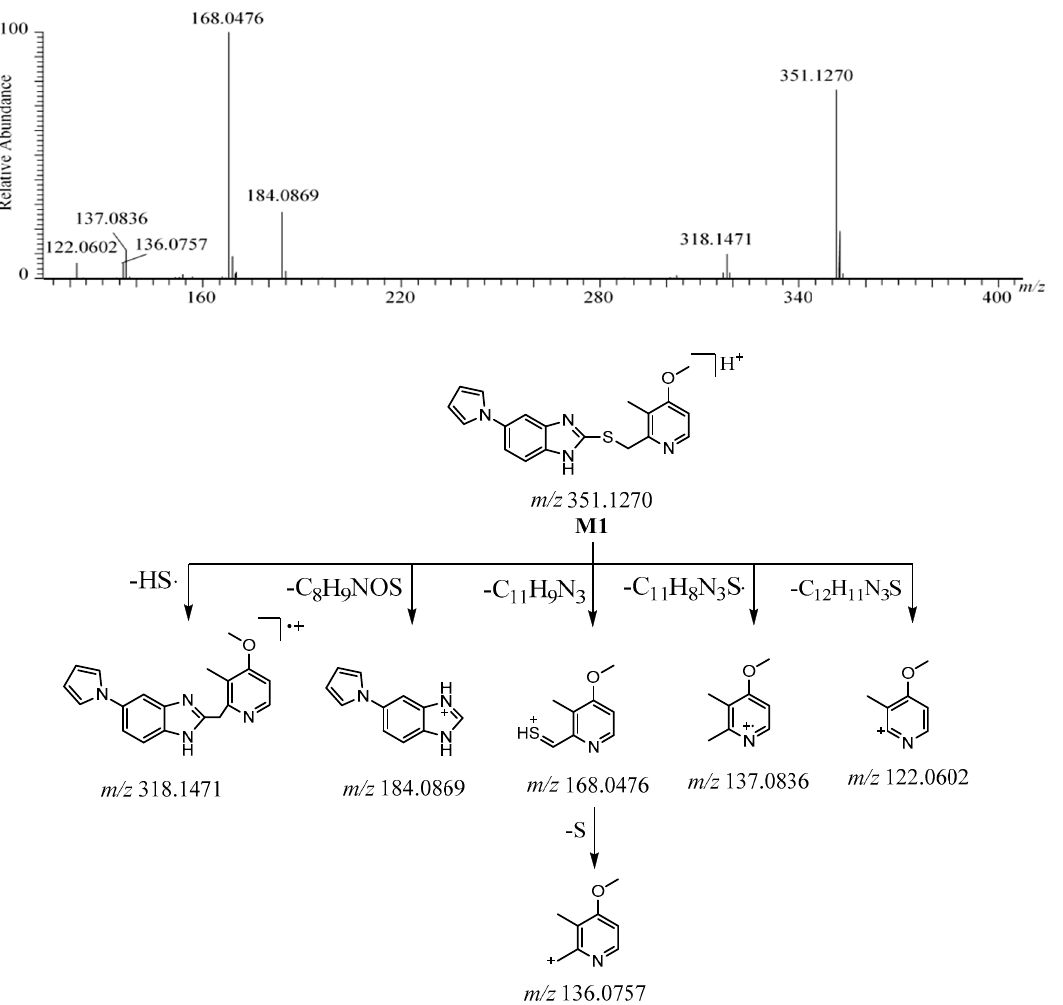
Figure 4. The HRMS/MS spectrum and the possible fragmentation pathway of